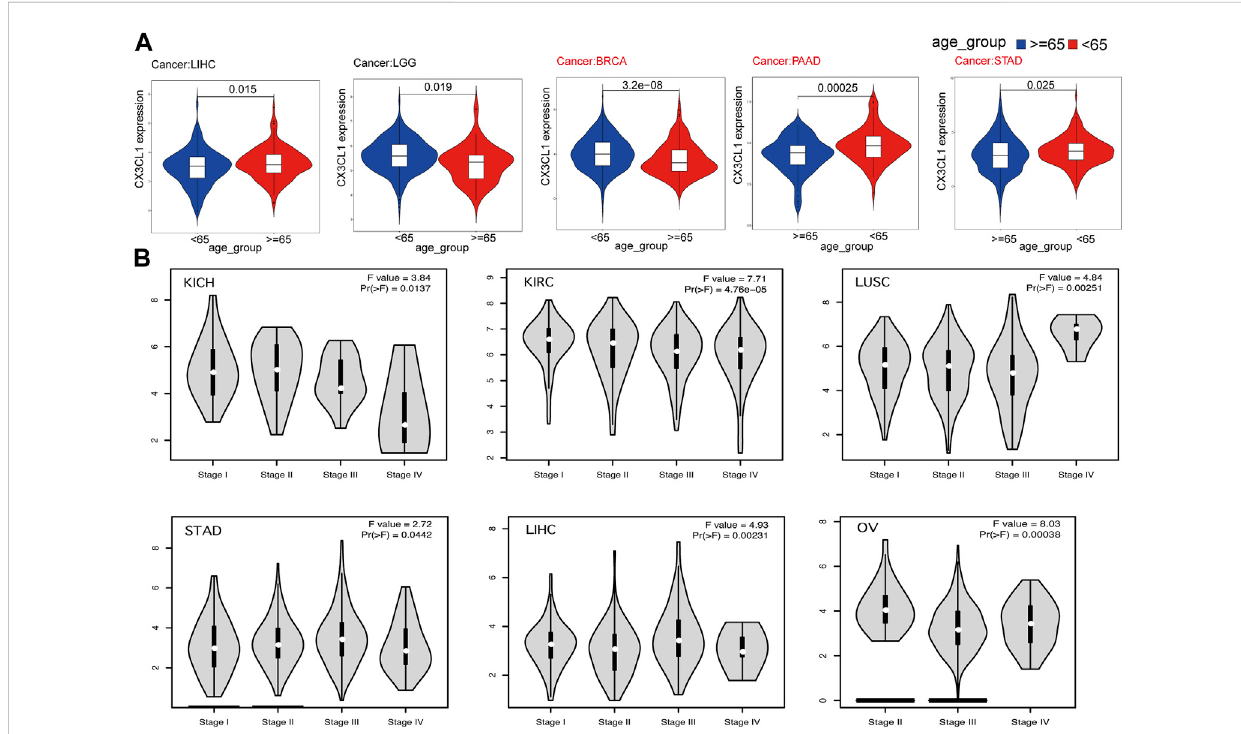
FIGURE 2 Correlations between the expression of CX3CL1 and clinicopathologic characteristics in pan-cancer. (A) CX3CL1 expression in patients of varying ages ( < 65 vs. ≥ 65 years) with different types of tumors, including LIHC, LGG, BRCA, PAAD, and STAD. (B) Correlations between differential expression of CX3CL1 and the pathological stages of KICH, KIRC, LUSC, STAD, LIHC, and